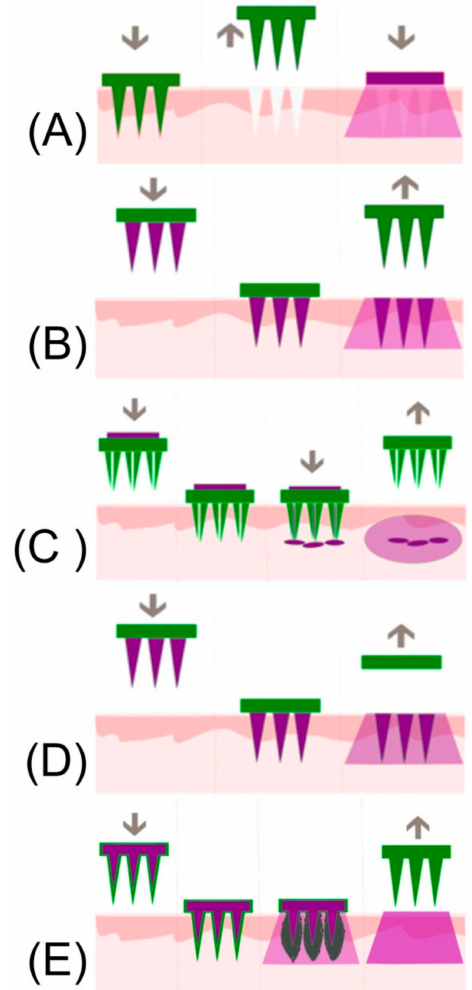
Figure 4. Mode of action inherent to solid ( A ), coated ( B ), hollow ( C ), dissolvable ( D ), and swellable ( E ) microneedle systems. (Reproduced with permission from